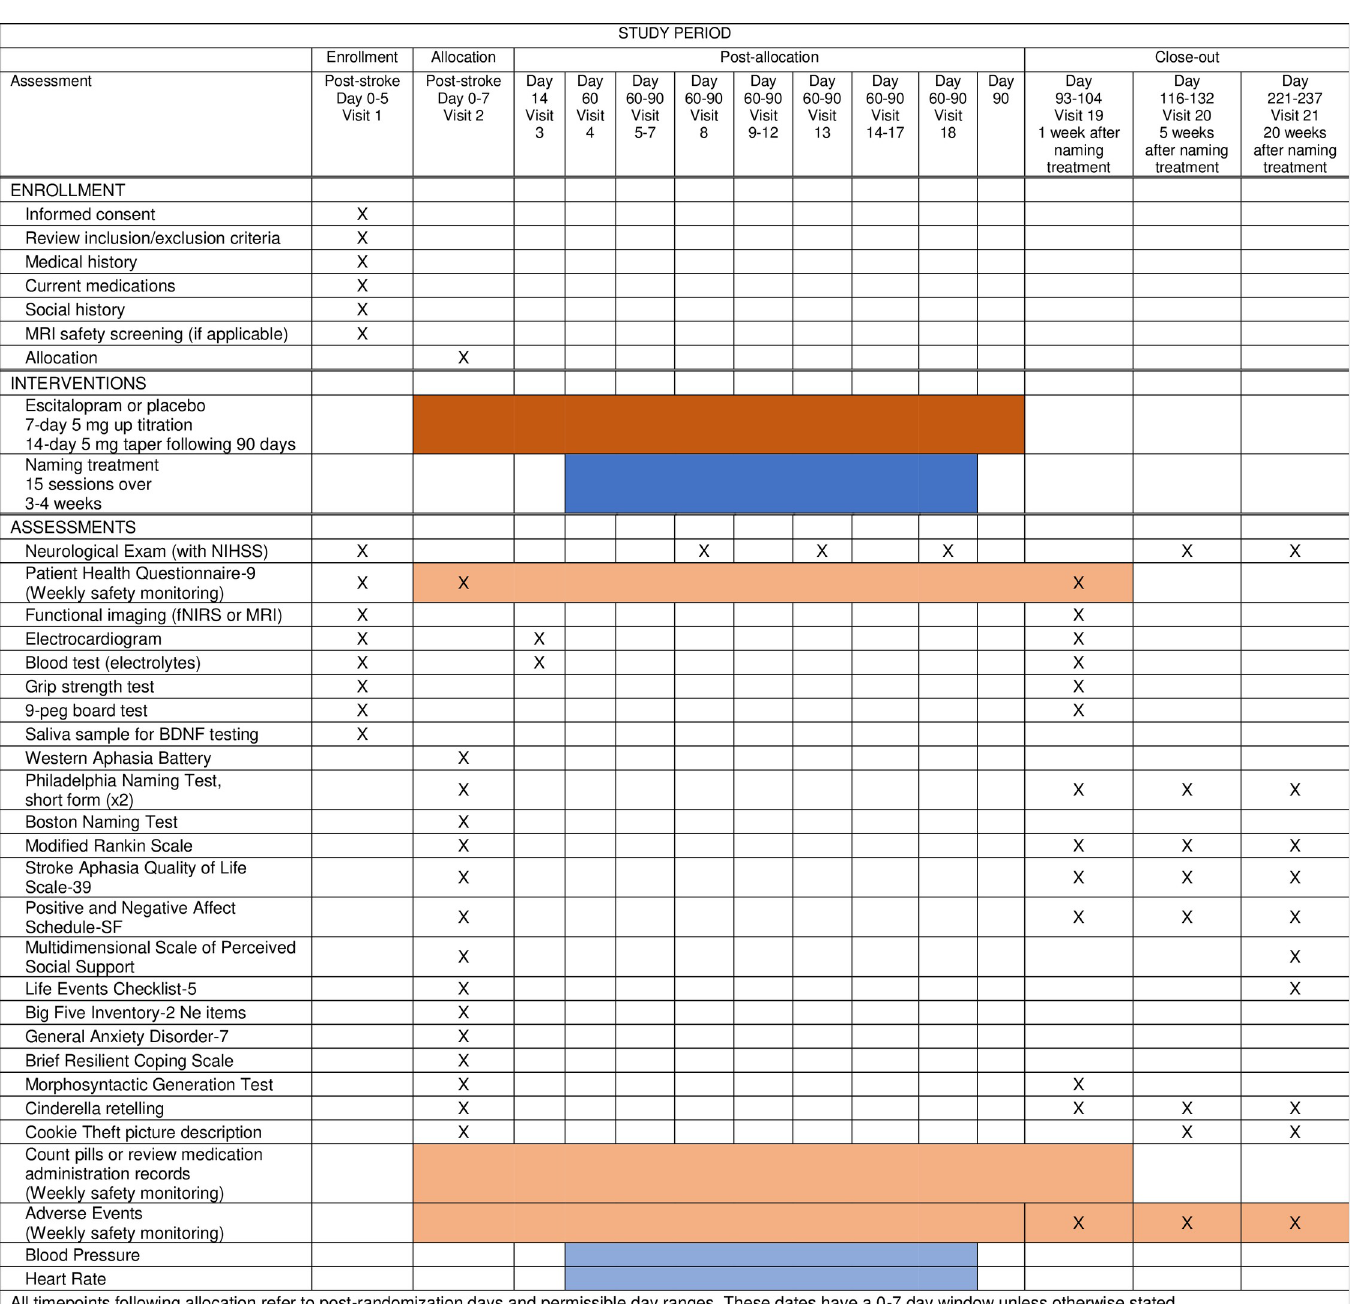
Fig 1. SPIRIT schedule of enrollment, interventions, and